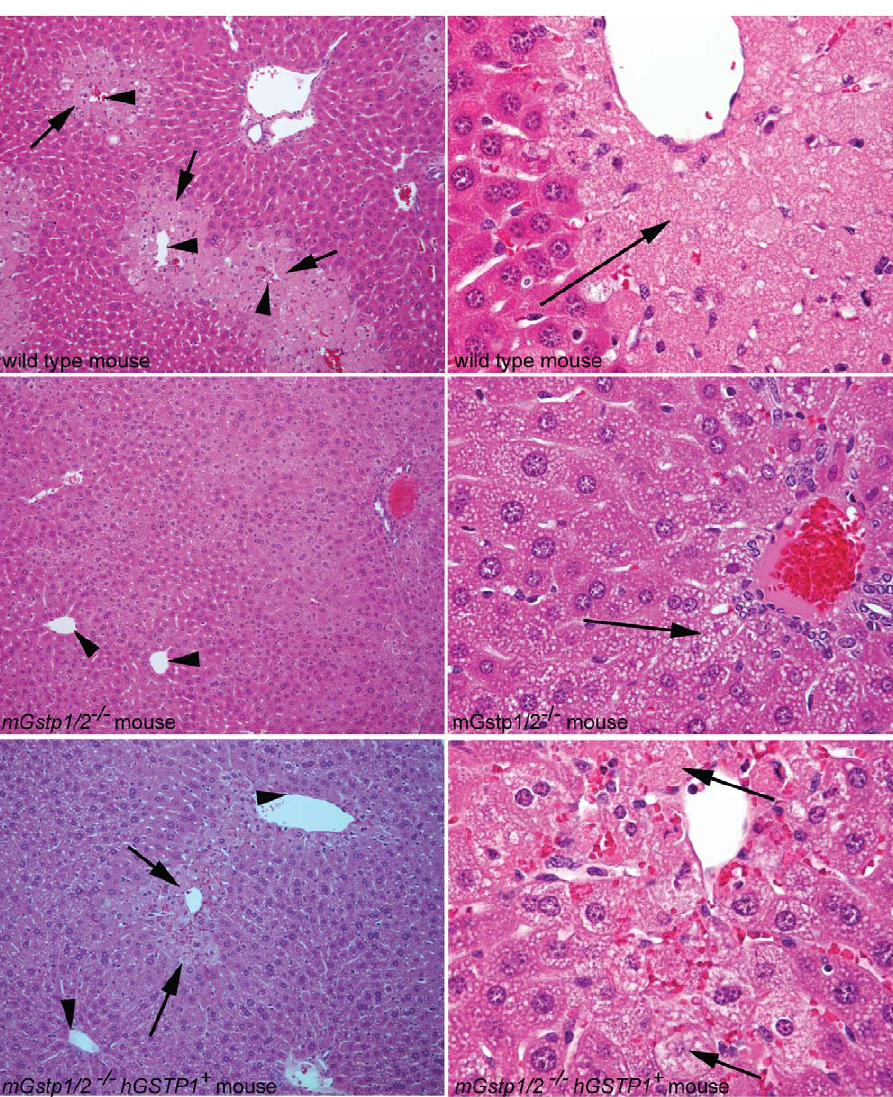
Figure 5. Histopathology of liver tissues from APAP-treated wild type, mGstp1/2 2 / 2 , and hGSTP1 + mGstp1/2 2 / 2 mice. Arrowheads denote central veins; arrows highlight liver injury/necrosis. Left panels are 200 6 original magnification and Right panels are 400 6 original magnification.